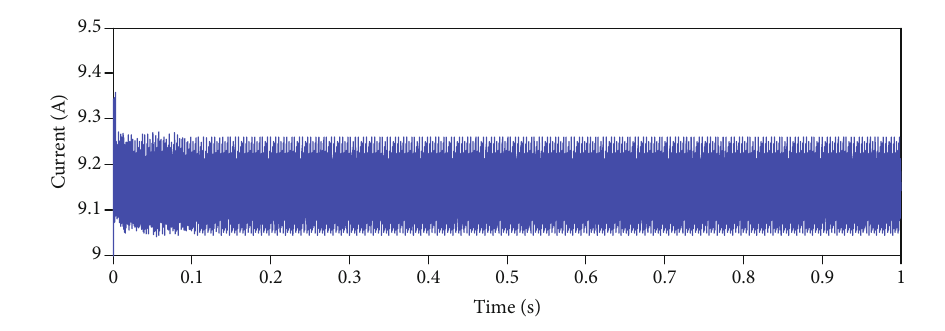
Figure 23: Current of PV2.